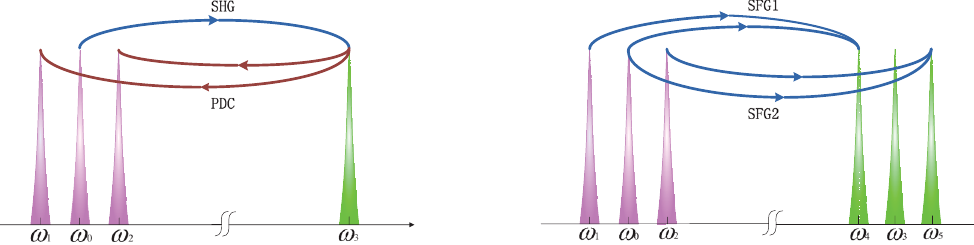
Figure 1. Second-harmonic generation (SHG) with cascaded down-conversion (PDC) process gives rise to the frequency components ω